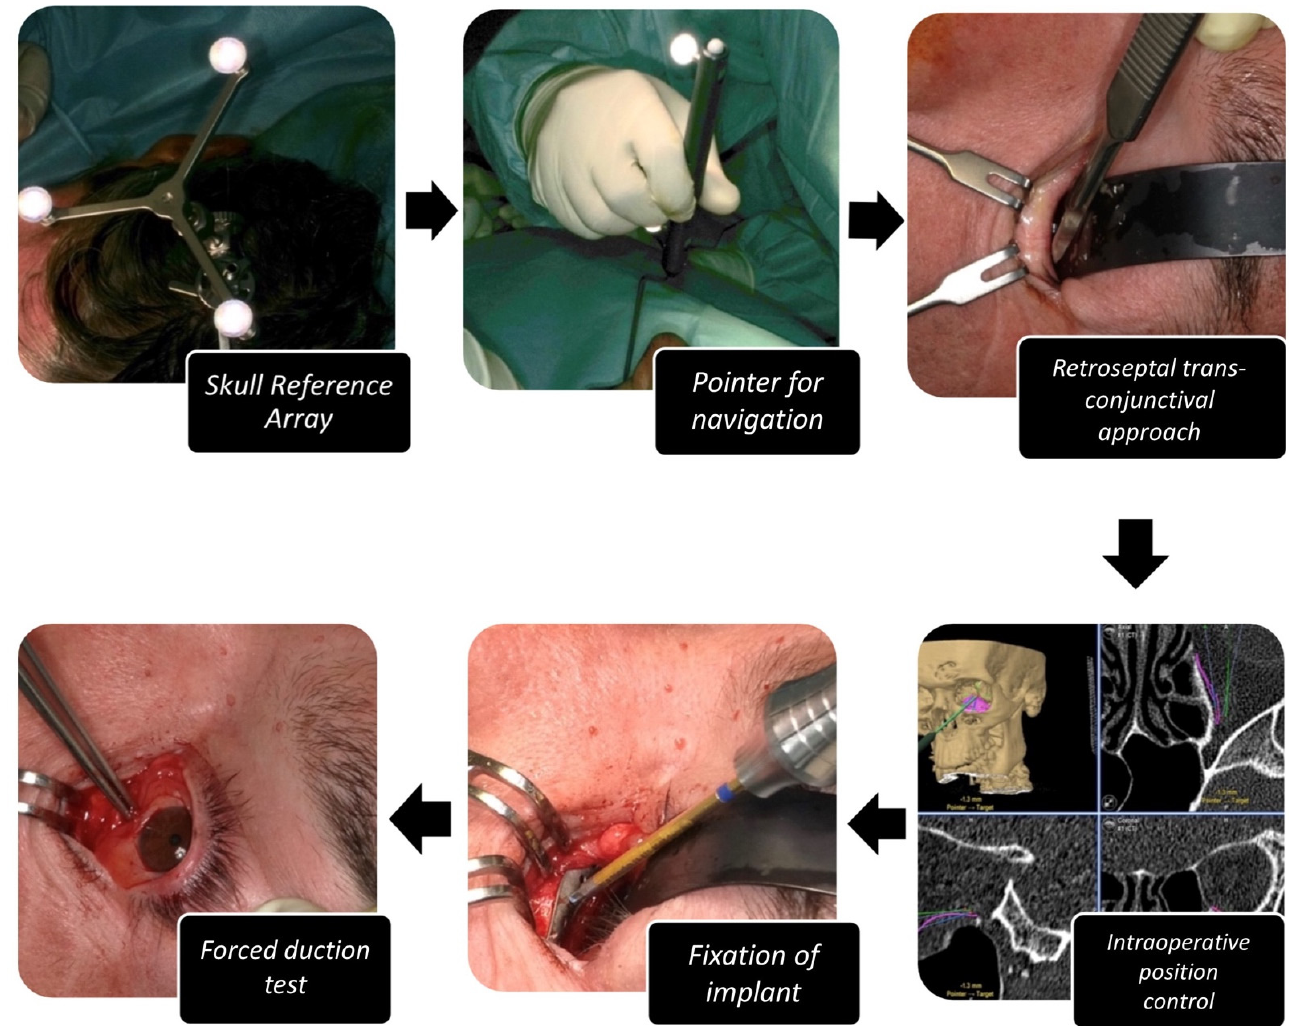
Figure 3. Operation procedure for computer-assisted, navigated PSI implantation for orbital recon- struction. The individual steps of set-up of navigation, approach, placement, fixation and placement control of PSI including forced duction test are shown.